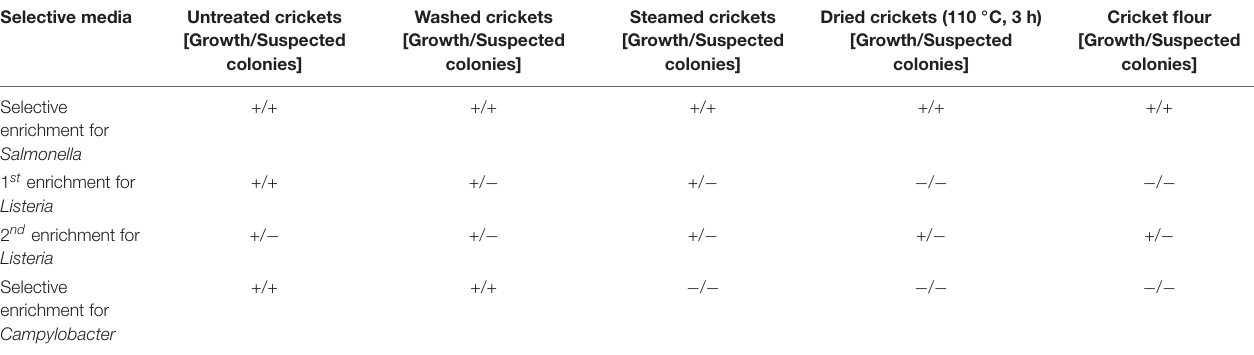
TABLE 5 | Growth on selective media after enrichment procedures with indication of the growth of suspected microorganisms. Selective